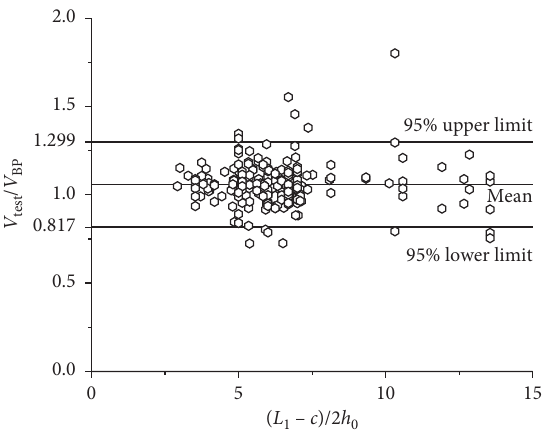
Figure 9: ( L − c ) /2 h influence on the BPNN model. 1 0